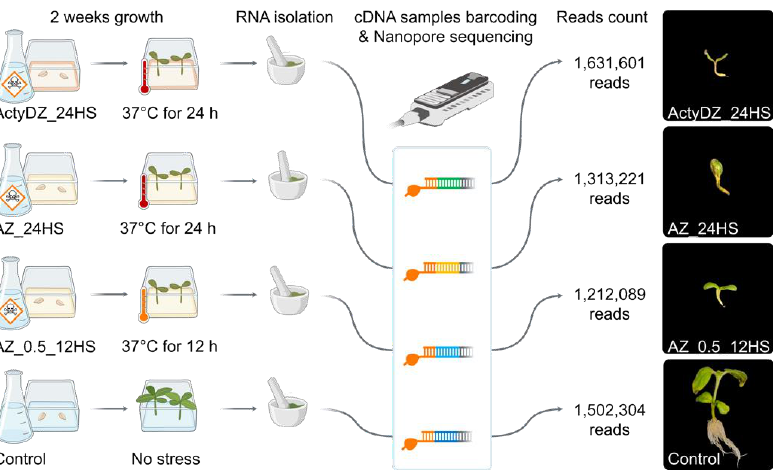
Figure 1. Experimental design of the epigenetic stress of sunflower performed by the heat stress of sunflower seeds germinated in an MS medium containing different concentrations of alpha-amanitin and zebularine toxins or no toxins (Control): AZ_0.5_12HS (2 µ g/mL alpha-amanitin, 4 µ g/mL zebularine, 12 h of heat stress (37 ◦ C)), AZ_24HS (4 µ g/mL alpha-amanitin, 8 µ g/mL zebularine, 24 h of heat stress (37 ◦ C), ActyDZ_24HS (4 µ g/mL actinomycin D, 8 µ g/mL zebularine, 24 h of heat stress (37 ◦ C)). Right panel shows the sunflower plant morphology three weeks after the seeds were placed on MS.